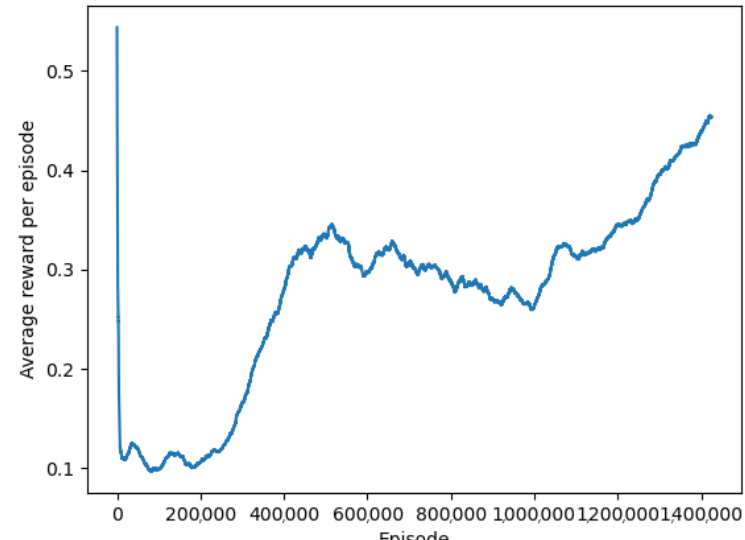
Figure 4. The average rewards obtained by the agent during the training with the A2C algorithm. The graph presents the values of the average number of tasks completed by the agent through the learning process, clearly visualising the achieved improvements over time. The initial high values of the rewards are related to an extraordinarily lucky run at the beginning of the learning, when the agent was moving absolutely at random—it should be noted that they are not present in the PPO